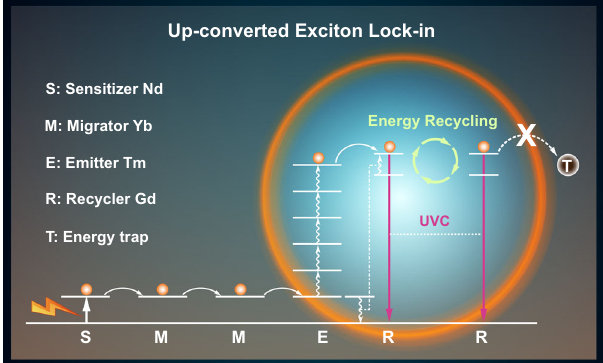
Fig. 1 Schematic illustration of upconverted excitation lock-in (UCEL) mechanism for UVC generation within a nanoparticle. The proposed UCEL scheme involving a heterogeneous, core-multishell nanostructure (Gd- CS Y S 2 S 3 ). A multistep cascade energy transfer (Nd 3 + → Yb 3 + → Tm 3 + → Gd 3 + ) leads to populate the excited states of Gd 3 + . The layer of an optical inert NaYF 4 host lattice doped with 20% Yb 3 + locating in the fi rst shell layer of nanoparticles can lock-in the upconverted excitation energy of Gd 3 + ions and prevent depopulation by deleterious energy traps within the nanoparticles, resulting in intense UVC upconversion emission. S, M, E, R, and T denote sensitizer Nd 3 + , migrator Yb 3 + , emitter Tm 3 + , recycler Gd 3 + , and energy traps,